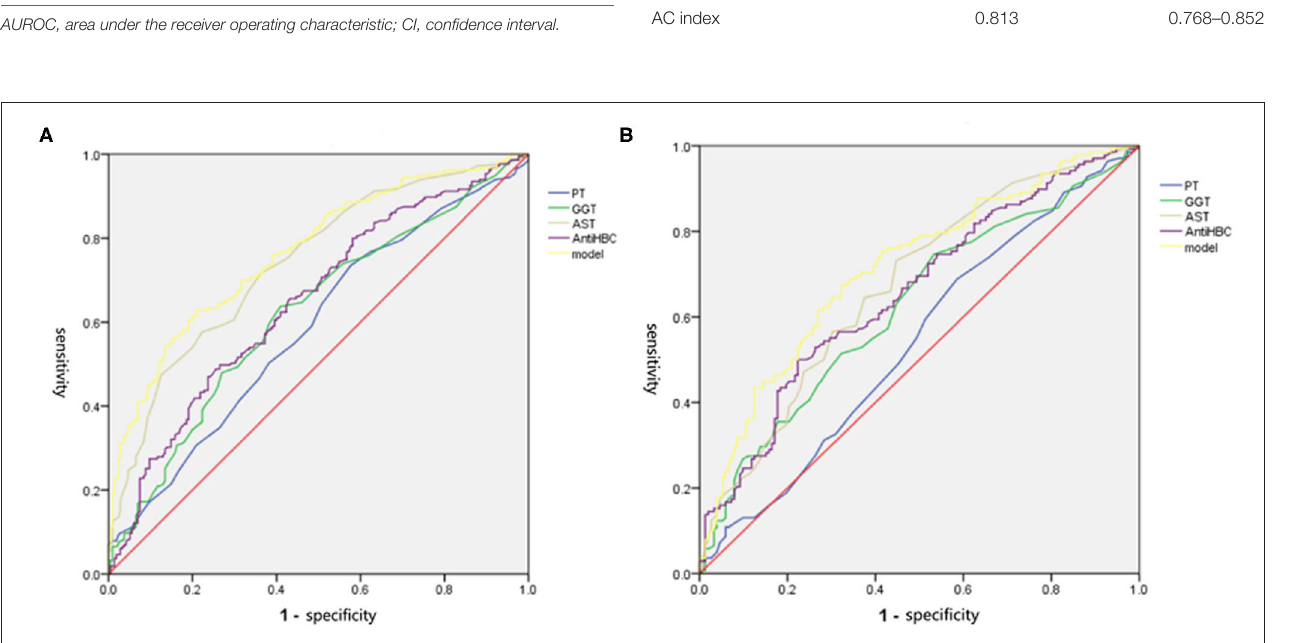
FIGURE 3 | The ROC of independent variables and the model values for identifying moderate to severe inflammation in the training and validation set. (A) In the training set, the AUROC of the model values was 0.767, which was higher than that for AST (0.741), PT (0.586), GGT (0.621), and Anti-HBC (0.648) alone. (B) In the validation set, the AUROC of the model values was 0.714, which was higher than that for AST (0.674), PT (0.542), GGT (0.624), and Anti-HBC (0.656) alone. AST, aspartate aminotransferase; PT, prothrombin time; GGT, glutamyl transpeptidase; Anti-HBC, anti-hepatitis B virus core antibody; AUROC, area under the receiver operating characteristic